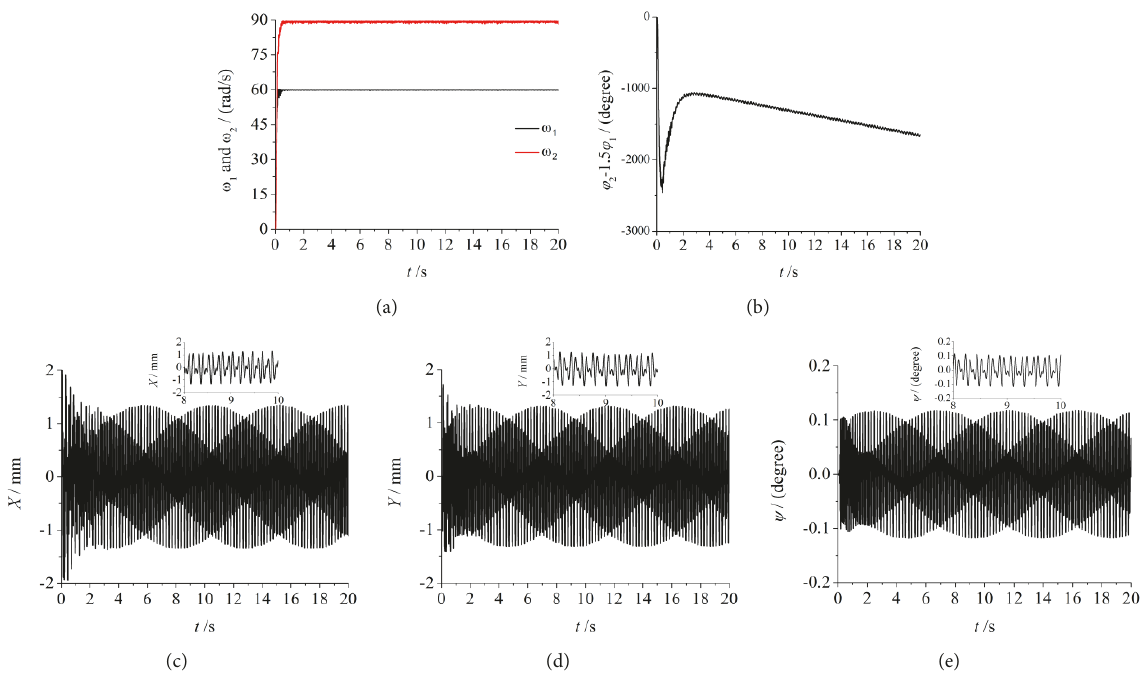
Figure 6: The multifrequency self-synchronization on the situation 𝑛 = 1.2 , where 𝛼 0 = 0 , with 𝛼 0 being the initial phase difference. (a) Speeds of the motors; (b) phase difference; (c) response of the 𝑥 direction; (d) response of the 𝑦 direction; (e) response of the 𝜓 direction.